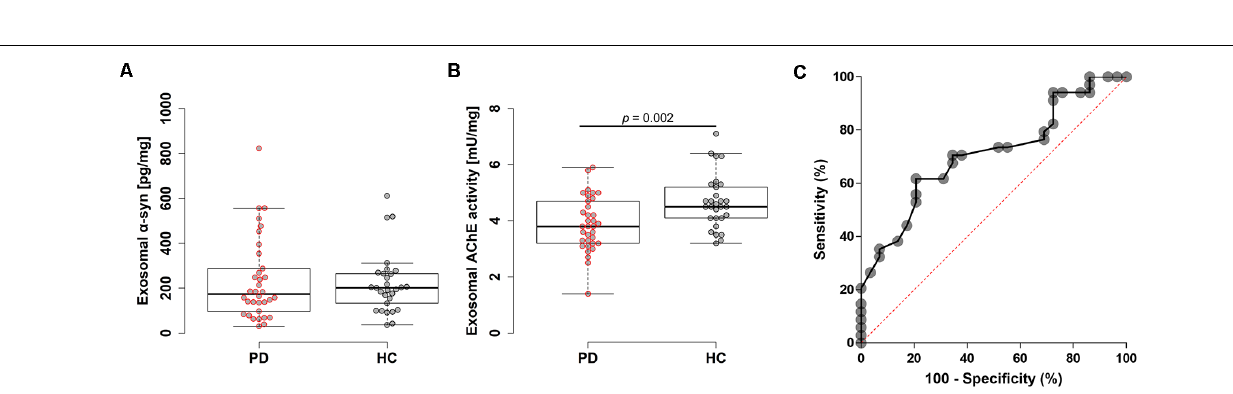
FIGURE 2 | Evaluation of plasma exosomal biomarkers. Box plots of exosomal α -syn levels (A) and acetylcholinesterase (AChE) activity (B) . Boxes represent the interquartile range; the horizontal lines mean medians and the whiskers. The Student’s t -test was used for comparison of the two groups. (C) Receiver operating characteristic (ROC) analysis of exosomal AChE